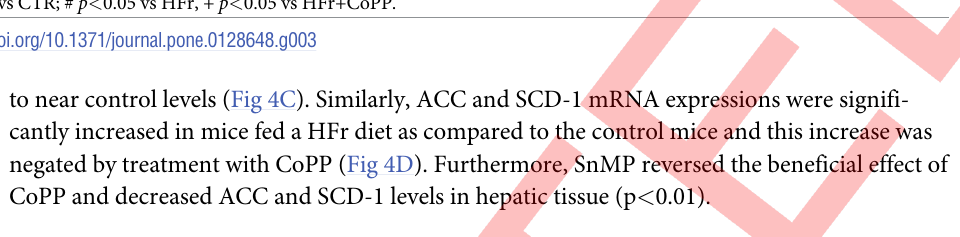
Fig 3. Effect of induction of HO-1 (CoPP) and inhibition of HO (SnMP) on metabolic profile and hepatic lipid content in mice fed a high fructose diet for 8 weeks. (A) Blood pressure. (B) Fasting blood glucose levels. (C) HOMA-IR (D) Plasma ALT levels. (E) Triglycerides levels in hepatic tissue. (F) Cholesterol levels in hepatic tissue. Results are mean ± SE, n = 6/group. �